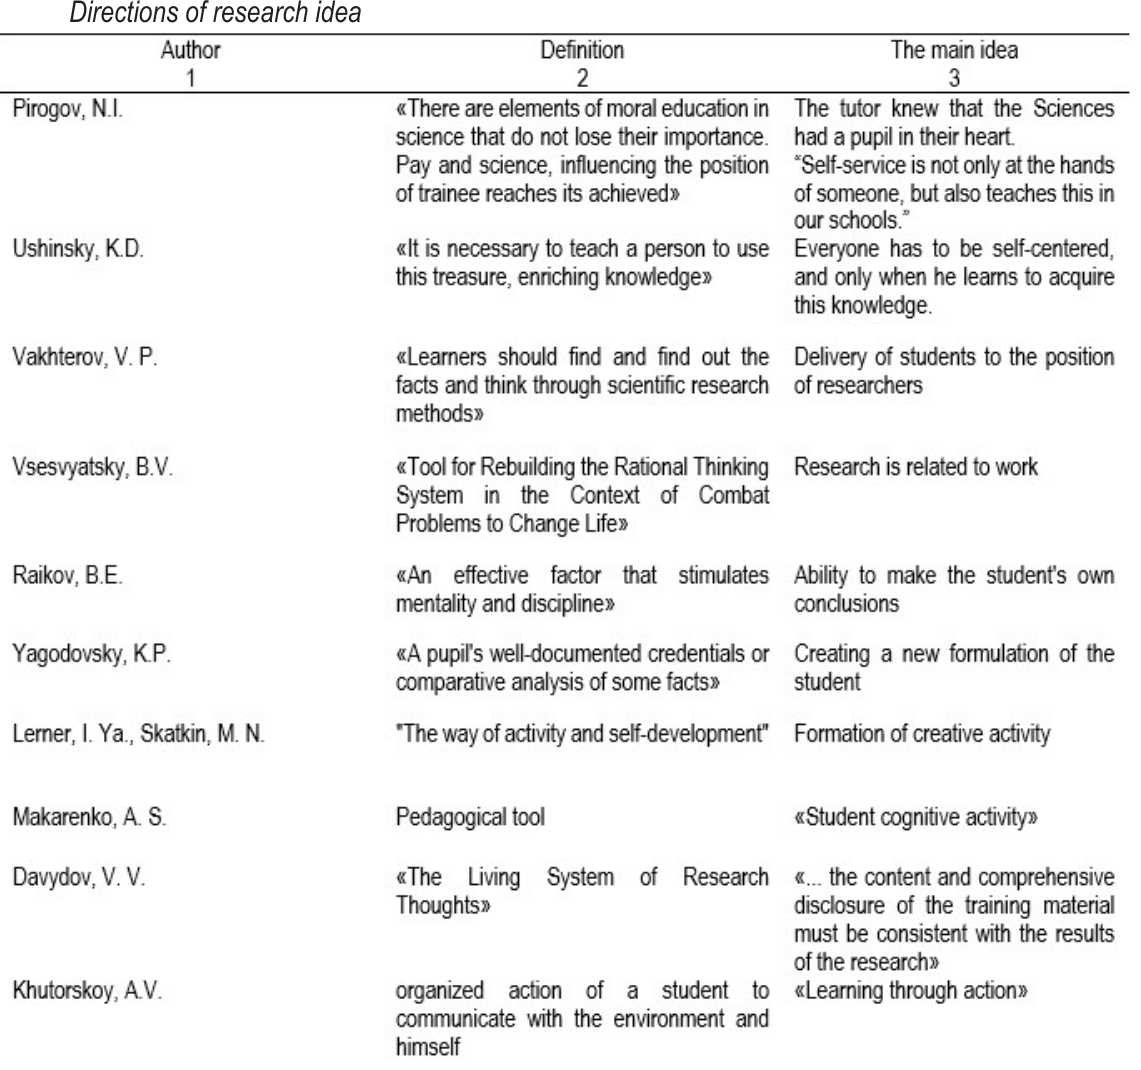
Directions of research